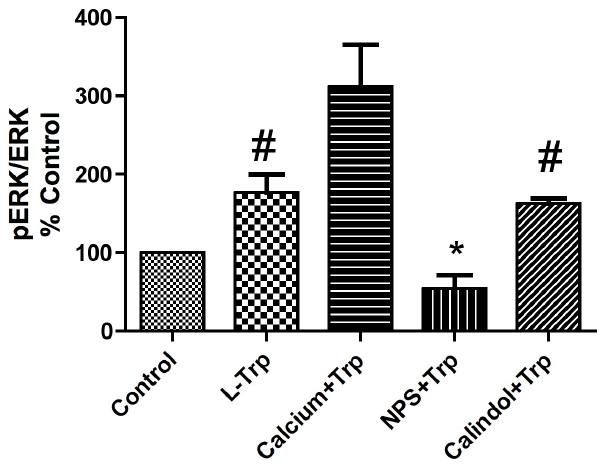
Figure 6. Modulatory effects of calcium on Tryptophan stimulated ERK phosphorylation. Erk (phospho Erk/Total Erk) assesed by Western blots of BMMSCs grown under normoxic conditions (21% O 2 /5% CO 2 ). When cells were 80% confluent, they were treated with either Trp alone (100 m M) or in combination with either additional extracellular calcium (baseline calcium: 1.2 mM increased to 1.8 mM) or a calcium receptor antagonist (NPS 10 nM) in serum-free media. The cells were washed twice with PBS and lysis buffer was added to the plates. Results are expressed as means 6 SEM for at least three independent experiments. * p # 0.05 and # p #